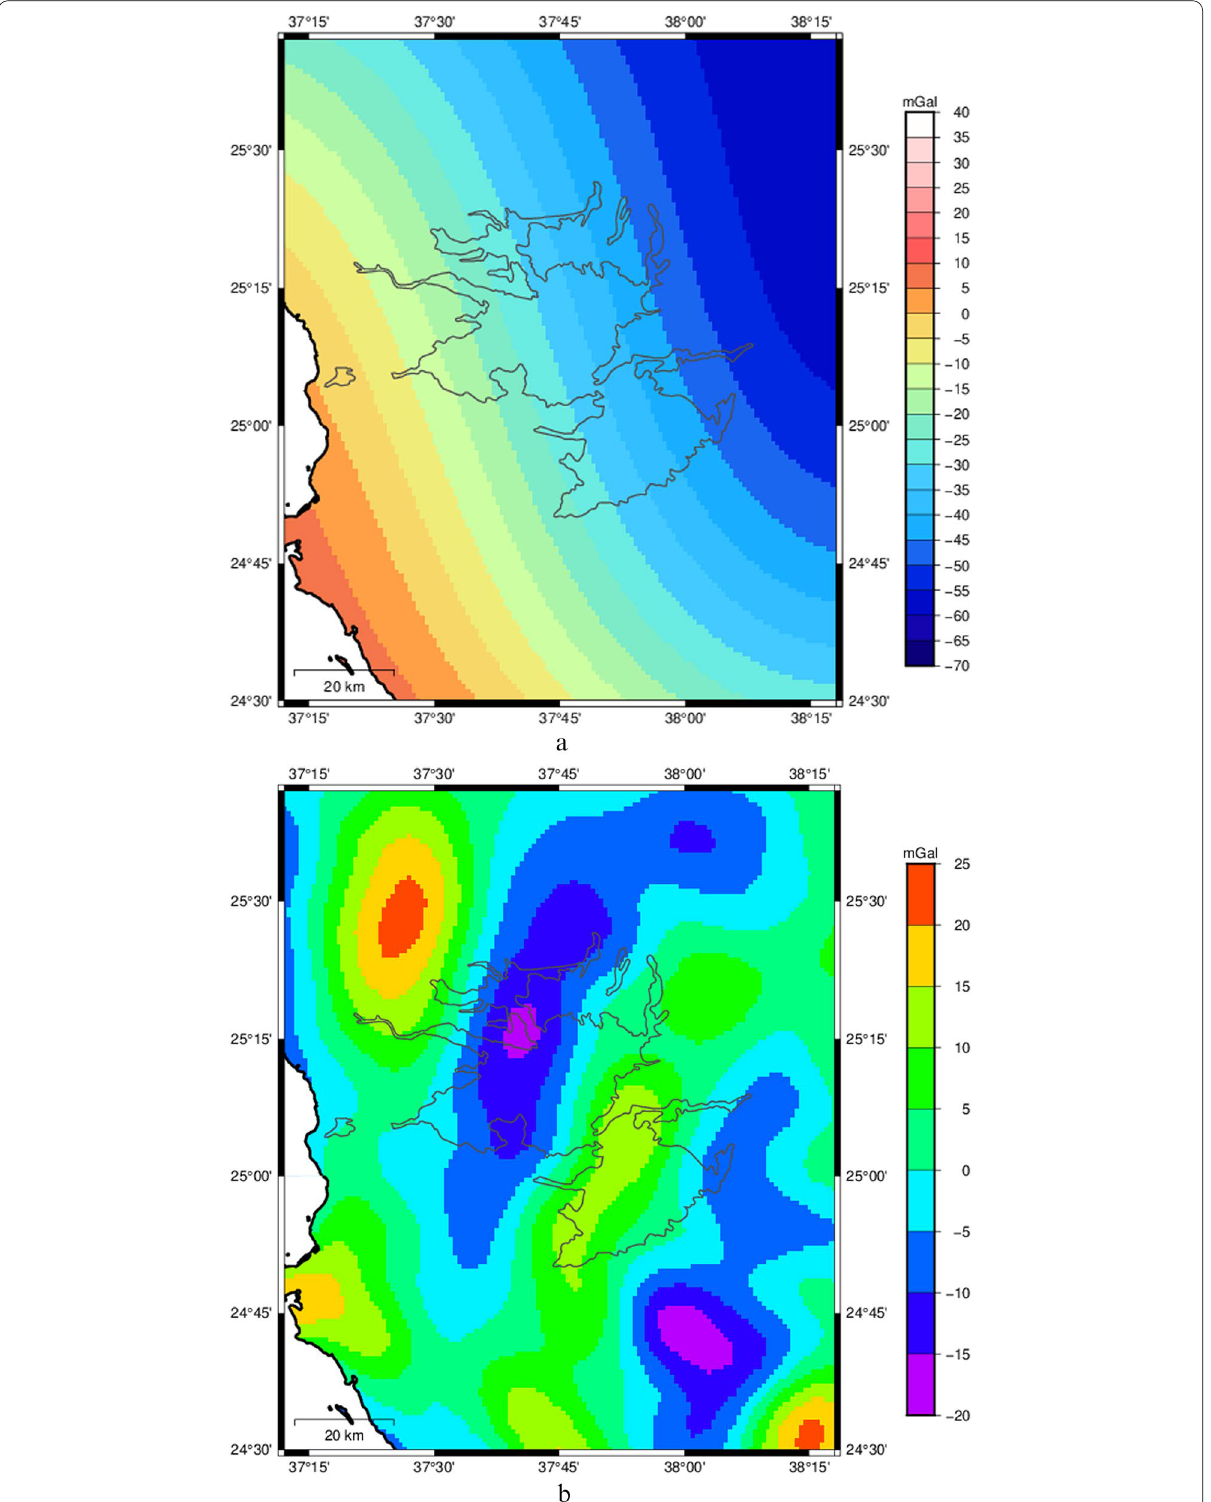
Fig. 4 a Regional anomaly map obtained by third order polynomial fitting of the observed Bouguer anomaly. Values are in mGal. b Residual anomaly map obtained after extraction of the regional from the observed Bouguer anomaly. Values are in